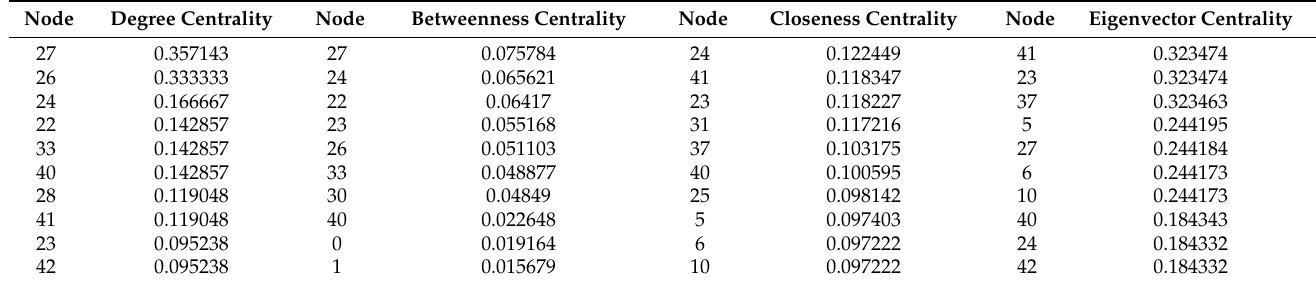
Table 2. Node importance index values for assembly quality analysis